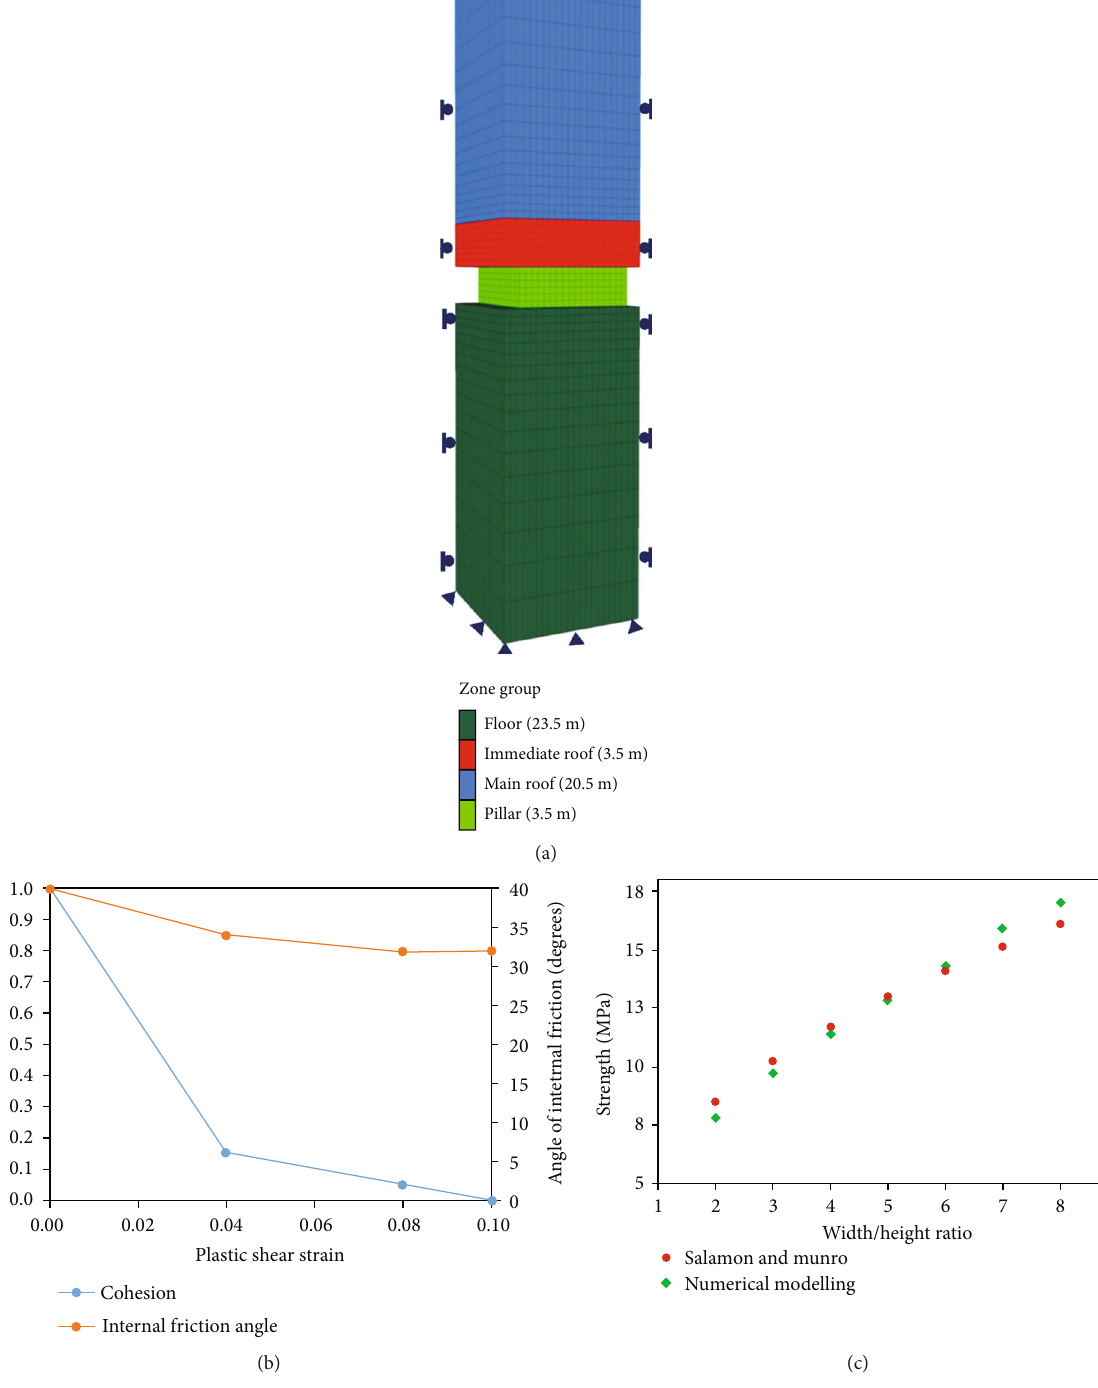
Figure 7: (a) Pillar submodel for strain softening calibration. (b) Cohesion and friction drop against plastic shear strain. (c) Strength value comparison using Salamon and Munro ’ s empirical formula and numerical